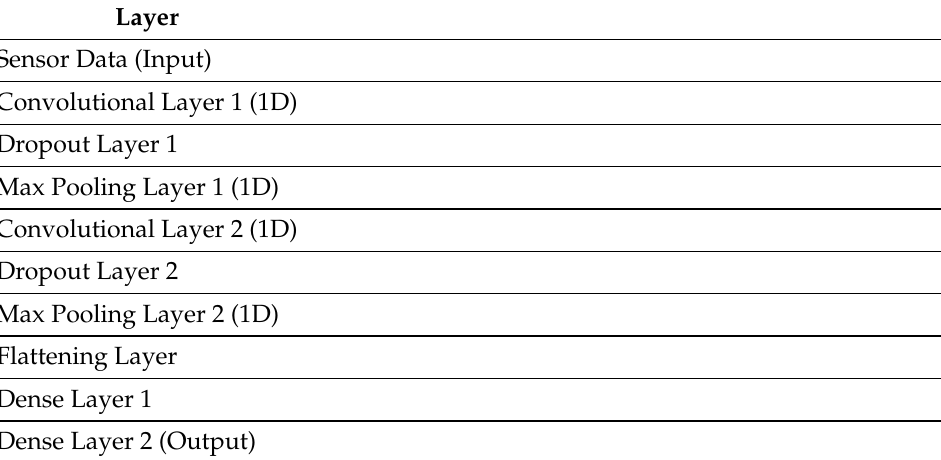
Table 6. Chosen CNN architecture.